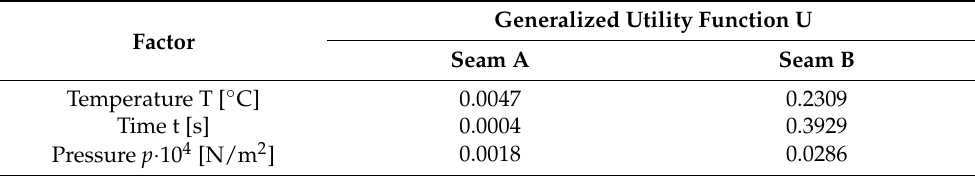
Table 4. Comparison of values of statistical significance p for the factors T, t, p